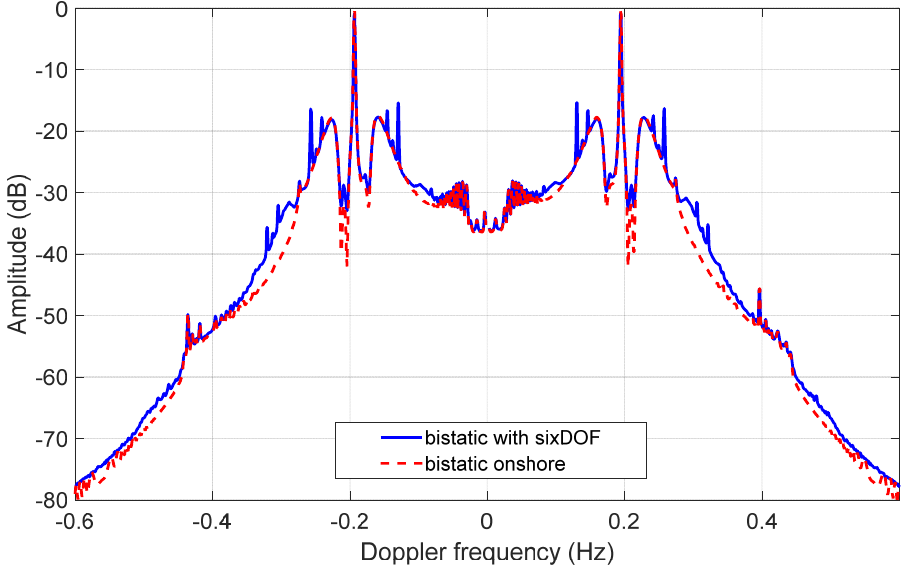
Figure 9. Simulated total RCSs containing first- and second-order RCSs.